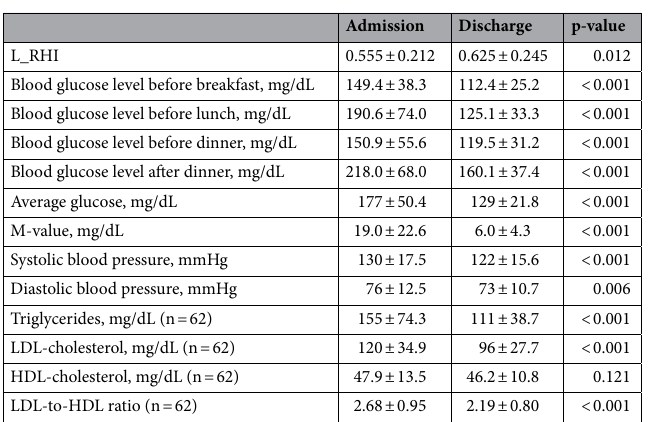
Table 3. L_RHI, blood glucose, blood pressure, and serum lipid parameters at admission and discharge (n = 65). Data are mean ± standard deviation, n, or n (%). L_RHI, natural logarithmically scaled reactive hyperemia index; LDL, low-density lipoprotein; HDL, high-density